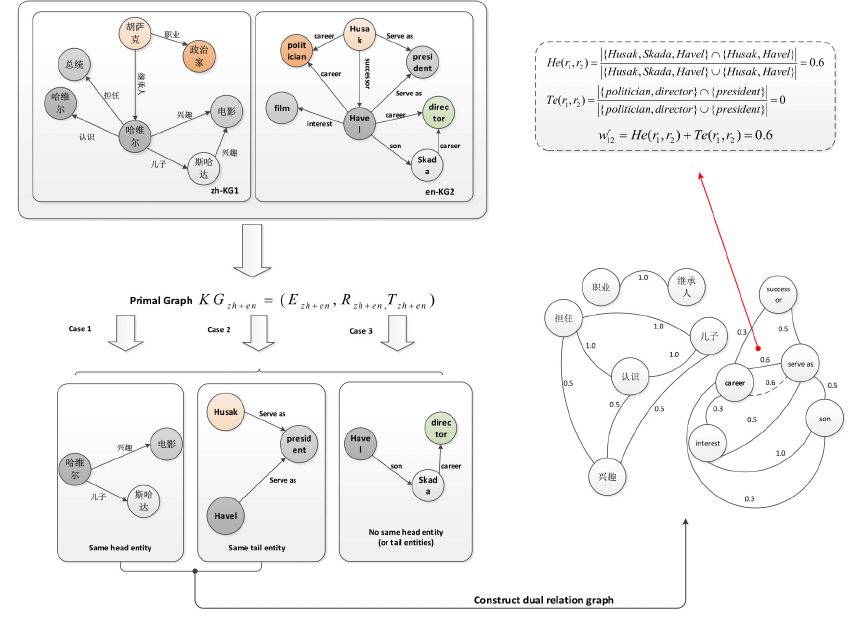
Figure 5. An example of constructing dual-relation graph. zh-KG1 and en-KG2 represent the Chinese knowledge graph and English knowledge graph,